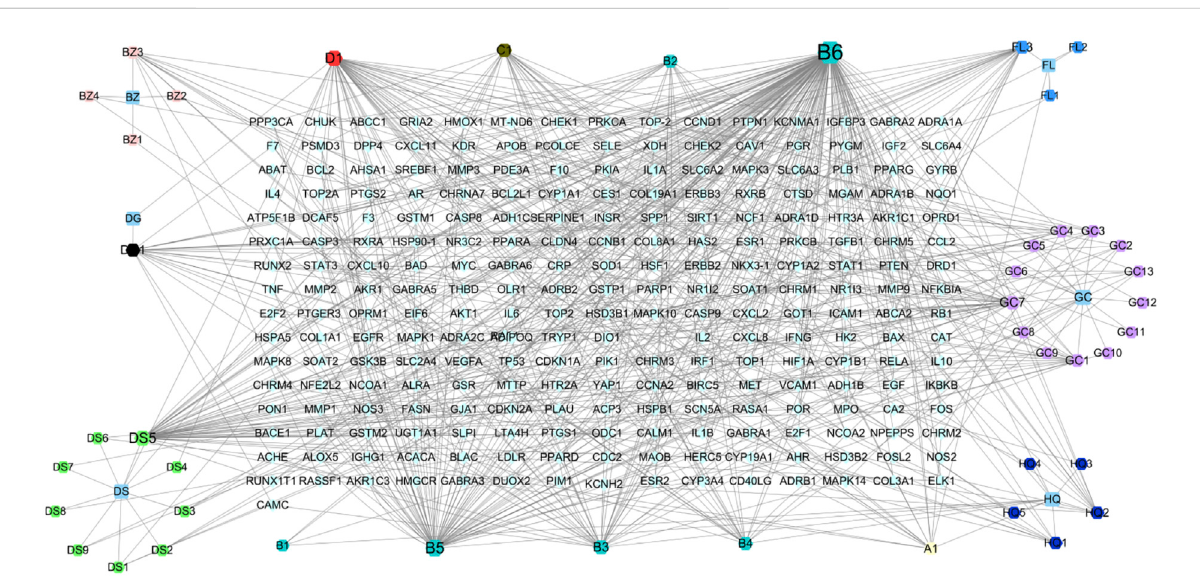
FIGURE 12 Thebotanicaldrugs-component-targetdiagram. The rhombus isthetarget, thehexagon istheeffective componentofbotanicaldrug, andthe square is the botanical drugs. (A1) refers to hederagenin, the common compound of Astragalus mongholicus Bunge Fabaceae. [Fabaceae; Astragali Radix]andPoriacocos(Schw.)Wolf.[Polyporaceae;Poria]. (B1) Astragalus mongholicusBungeFabaceae.[Fabaceae;AstragaliRadix]and Glycyrrhiza uralensis Fisch. ex DC. [Fabaceae; Glycyrrhizae radix et rhizoma]. (B2) refers to Jaranol, the common compound of Astragalus mongholicus Bunge Fabaceae. [Fabaceae; Astragali Radix] and Glycyrrhiza uralensis Fisch. ex DC. [Fabaceae; Glycyrrhizae radix et rhizoma]. (B3) refers to isorhamnetin, the common compound of Astragalus mongholicus Bunge Fabaceae. [Fabaceae; Astragali Radix] and Glycyrrhiza uralensis Fisch. ex DC. [Fabaceae; Glycyrrhizae radix et rhizoma]. (B4) refers to formononetin, the common compound of Astragalus mongholicus Bunge Fabaceae. [Fabaceae; Astragali Radix] and Glycyrrhiza uralensis Fisch. ex DC. [Fabaceae; Glycyrrhizae radix et rhizoma]. (B5) refers to kaempferol, the common compound of Astragalus mongholicus Bunge Fabaceae. [Fabaceae; Astragali Radix] and Glycyrrhiza uralensis Fisch. ex DC. [Fabaceae; Glycyrrhizae radix et rhizoma]. (B6) refers to quercetin, the common compound of Astragalus mongholicus Bunge Fabaceae. [Fabaceae; Astragali Radix] and Glycyrrhiza uralensisFisch.exDC.[Fabaceae;Glycyrrhizaeradixetrhizoma]. (C1) refersto7-Methoxy-2-methyliso fl avone,thecommoncompound of Glycyrrhiza uralensis Fisch. ex DC. [Fabaceae; Glycyrrhizae radix et rhizoma] and Codonopsis pilosula (Franch.) Nannf. [Campanulaceae; Codonopsisradix]. (D1) refers to Stigmasterol, the common compound of Codonopsis pilosula (Franch.) Nannf. [Campanulaceae; Codonopsisradix] and Angelica sinensis (Oliv.) Diels [Apiaceae; Angelicae Sinensis